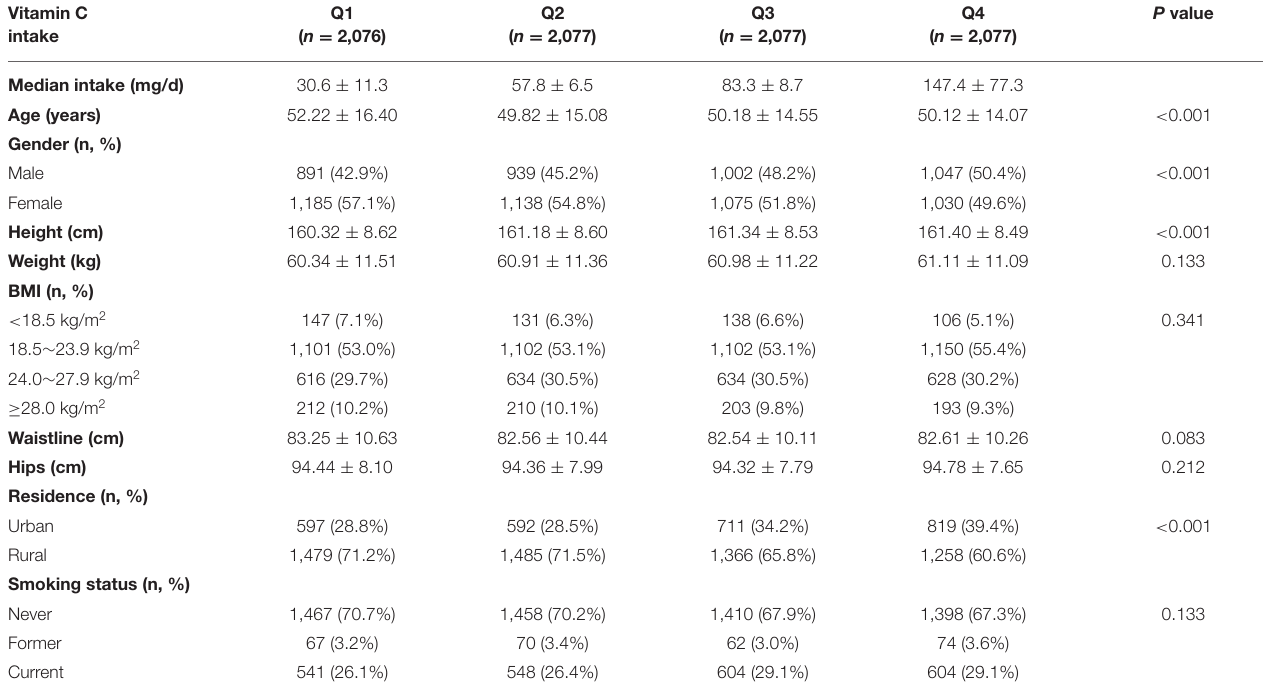
TABLE 1 | General characteristics of the participants.